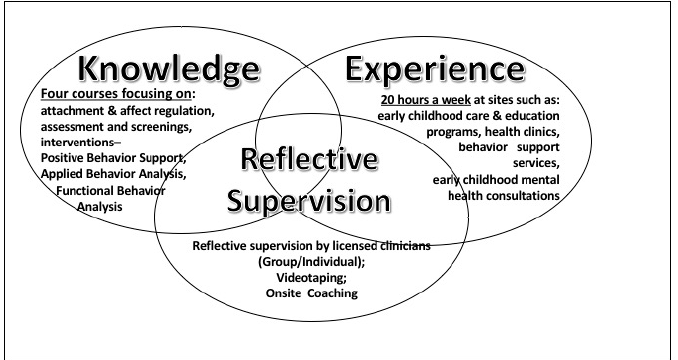
Figure 1. Early Childhood Social Emotional and Behavior Regulation Intervention Specialist (EC-SEBRIS) Certificate Triple Mode Teaching Model.